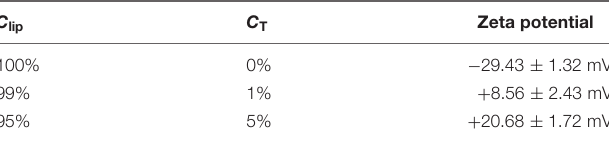
TABLE 1 | Zeta potential versus Ts-PEG2000-DSPE dosage (w/w).